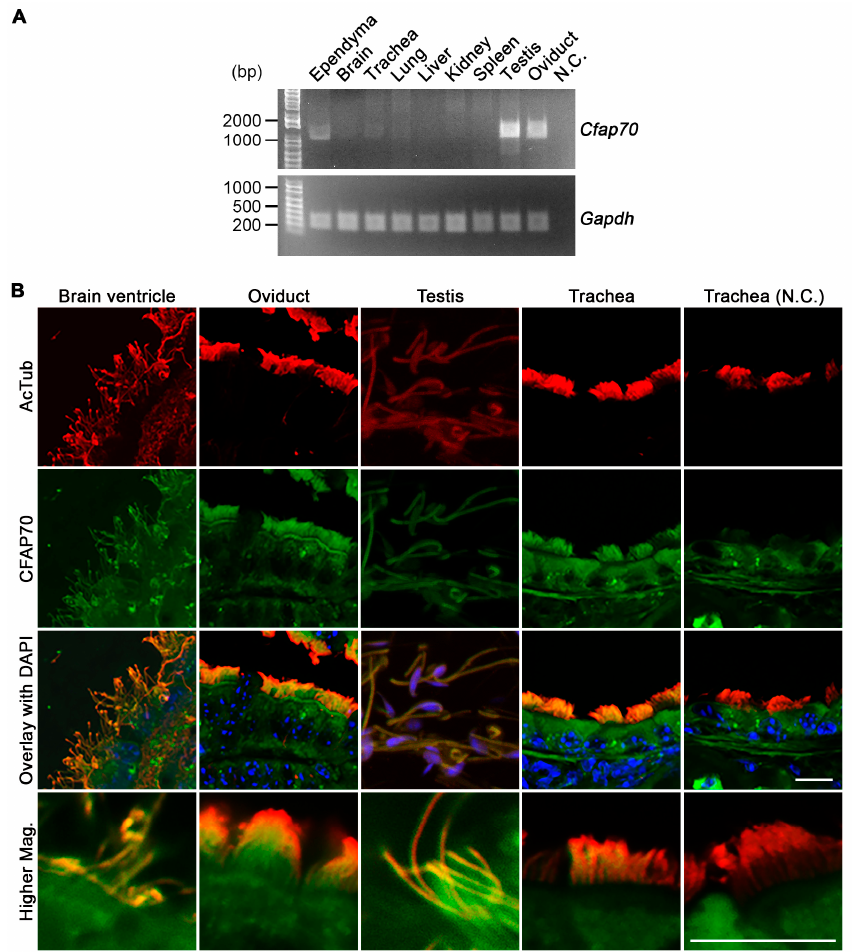
Figure 1. Detection of Cfap70 mRNA and protein in mouse. ( A ) Semi-quantitative RT-PCR analysis of various cells and tissues. To the left of the gel, the positions and sizes (bp) of DNA ladders are indicated. ( B ) Confocal microscopy of tissue sections immunostained for CFAP70 (green) and acetylated α -tubulin (AcTub, red) along with DAPI (blue). As a negative control (N.C.), a tracheal section was immunostained using mouse anti-AcTub and rabbit normal IgG. All of the CFAP70-positive epithelia and spermatocytes have motile 9 + 2 cilia and flagella. Bars, 10 µm.